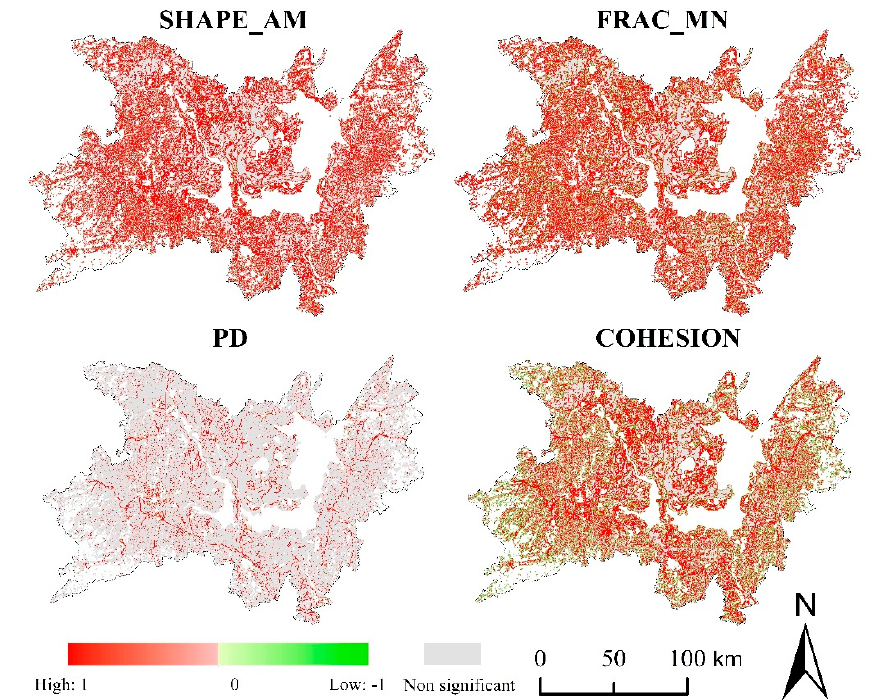
Figure 10. Time-series correlation of landscape pattern index (SHAPE_AM, area-weighted mean shape index; FRAC_MN, mean fractal dimension index; PD, patch density; COHESION, patch cohesion index).